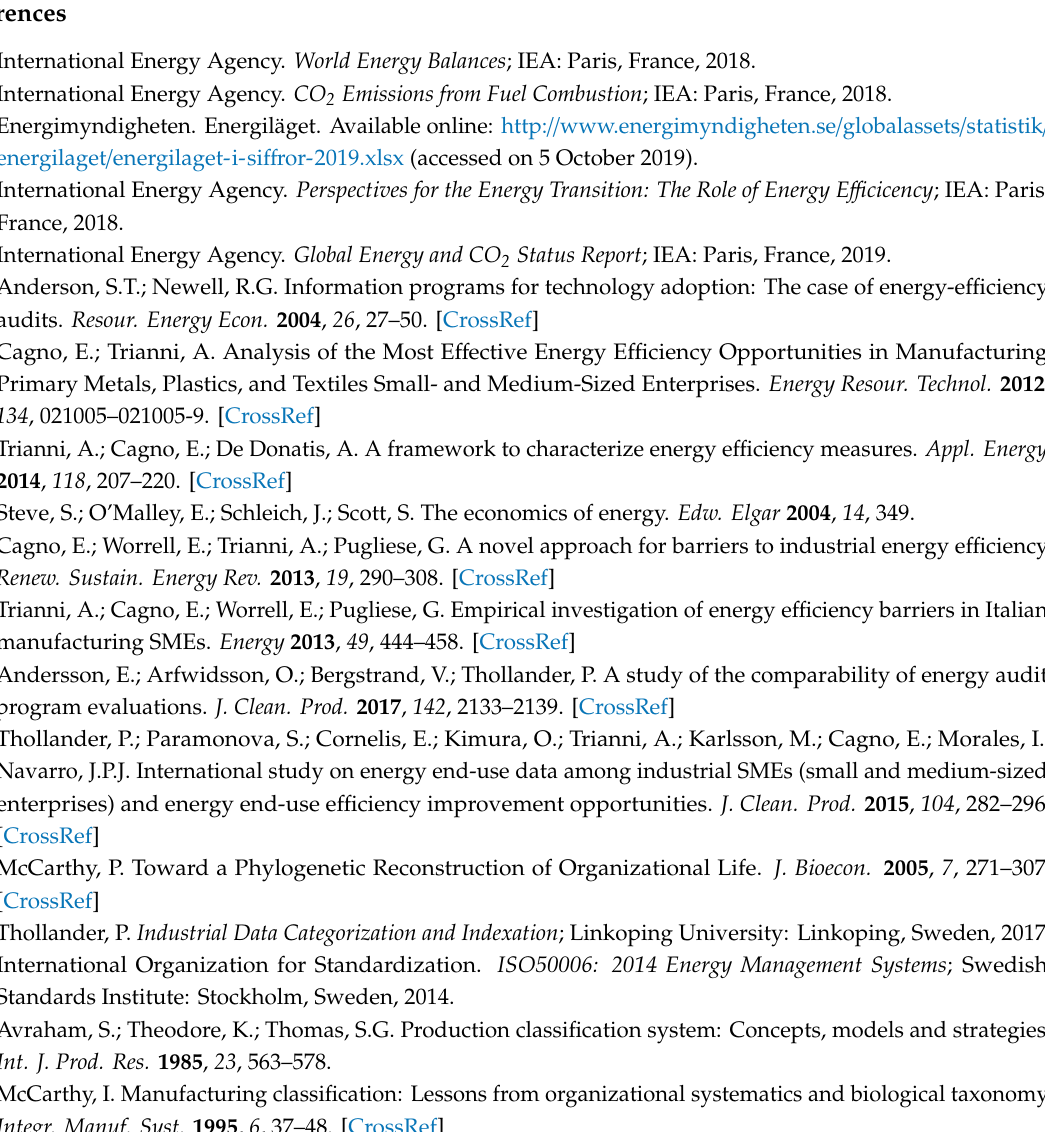
Figure A6. CO 2 emissions for the unit processes in the support category based on the case study of the engineering industry (Scenario 2).